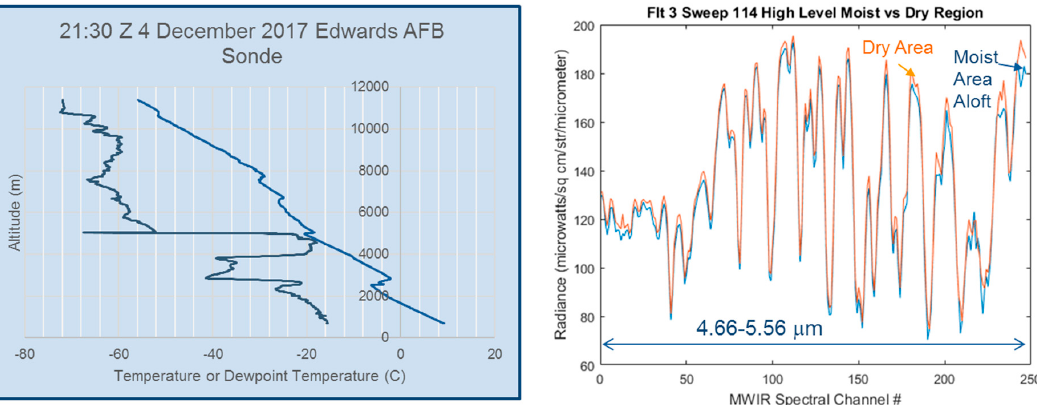
Figure 14. Clouds (and surrounding low-level water vapor field) under a higher-level water vapor field near Edwards Air Force Base were observed in a set of radiance images. Images from the spectral channels shown are a window channel (71, near 4.919 µ m) first with broader radiance range-and then narrowed range to highlight clouds) and images for spectral channels near local spectral radiance minima caused by water vapor absorption and emission, which show a sequence of decreasing average radiance with increasing wavelength, as shown at right in Figure 13. (Channels 64 → 80 → 98 → 115, or 4.894, 4.952, 5.017, and 5.079 µ m respectively are shown ). An area of moist air aloft, distinct from a dryer area (indicated in the lowest panel on the right), becomes increasingly apparent as spectral channels with increasing water vapor absorption strength are viewed.